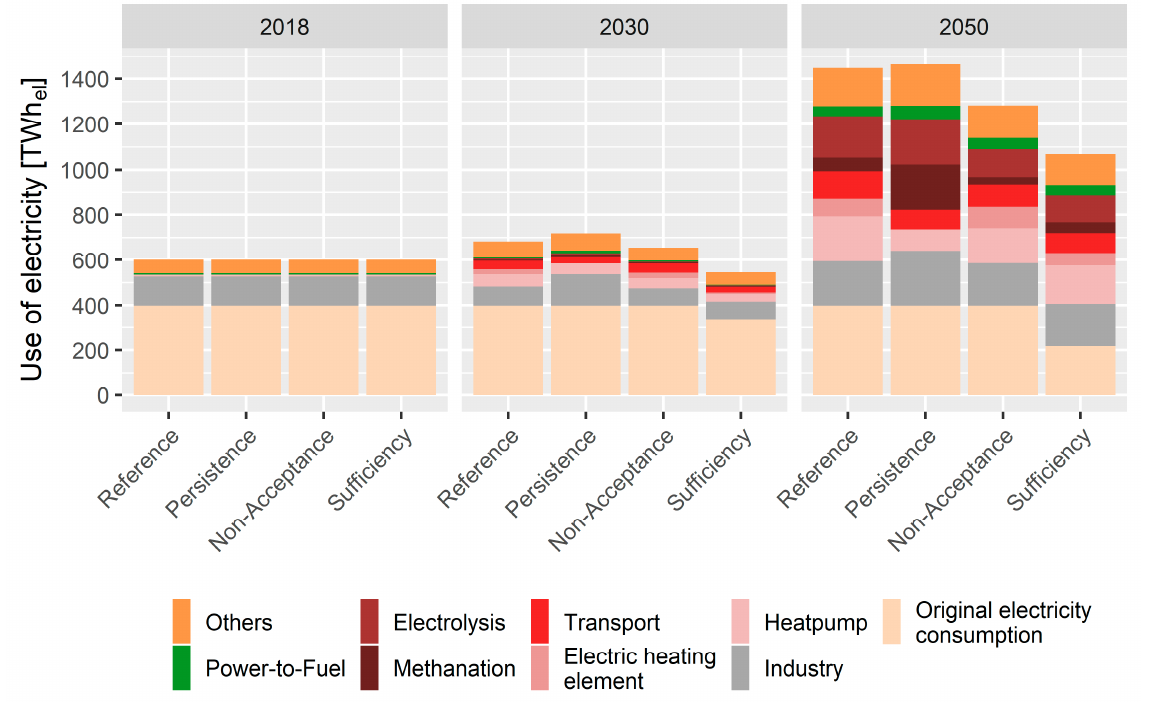
Figure 6. Use of electricity for 2018, 2030, and 2030 (results calculated with REMod).